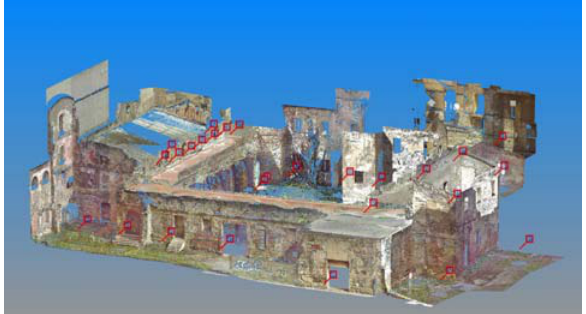
Figure 4: Positions of the outdoor scans in the survey of the St.